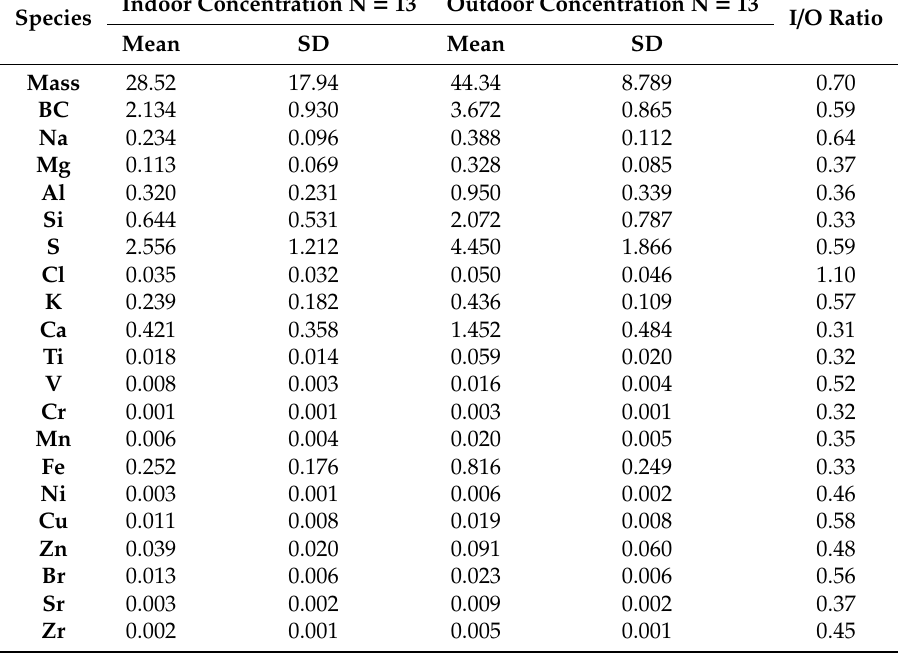
Table 1. Summary of mean and standard deviation indoor and outdoor PM 2.5 mass and species concentrations and their indoor-to-outdoor (I / O)